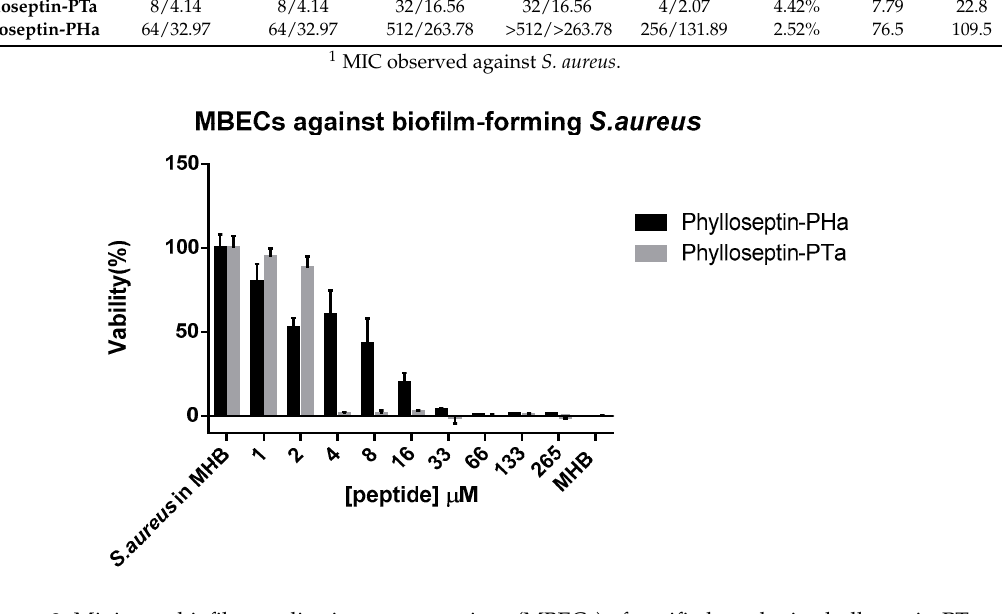
Figure 8. Minimum biofilm eradication concentrations (MBECs) of purified synthetic phylloseptin-PTa and phylloseptin-PHa against biofilm formed by S. aureus . Data represent means ± standard error of mean (SEM) of three independent experiments with five replicates.